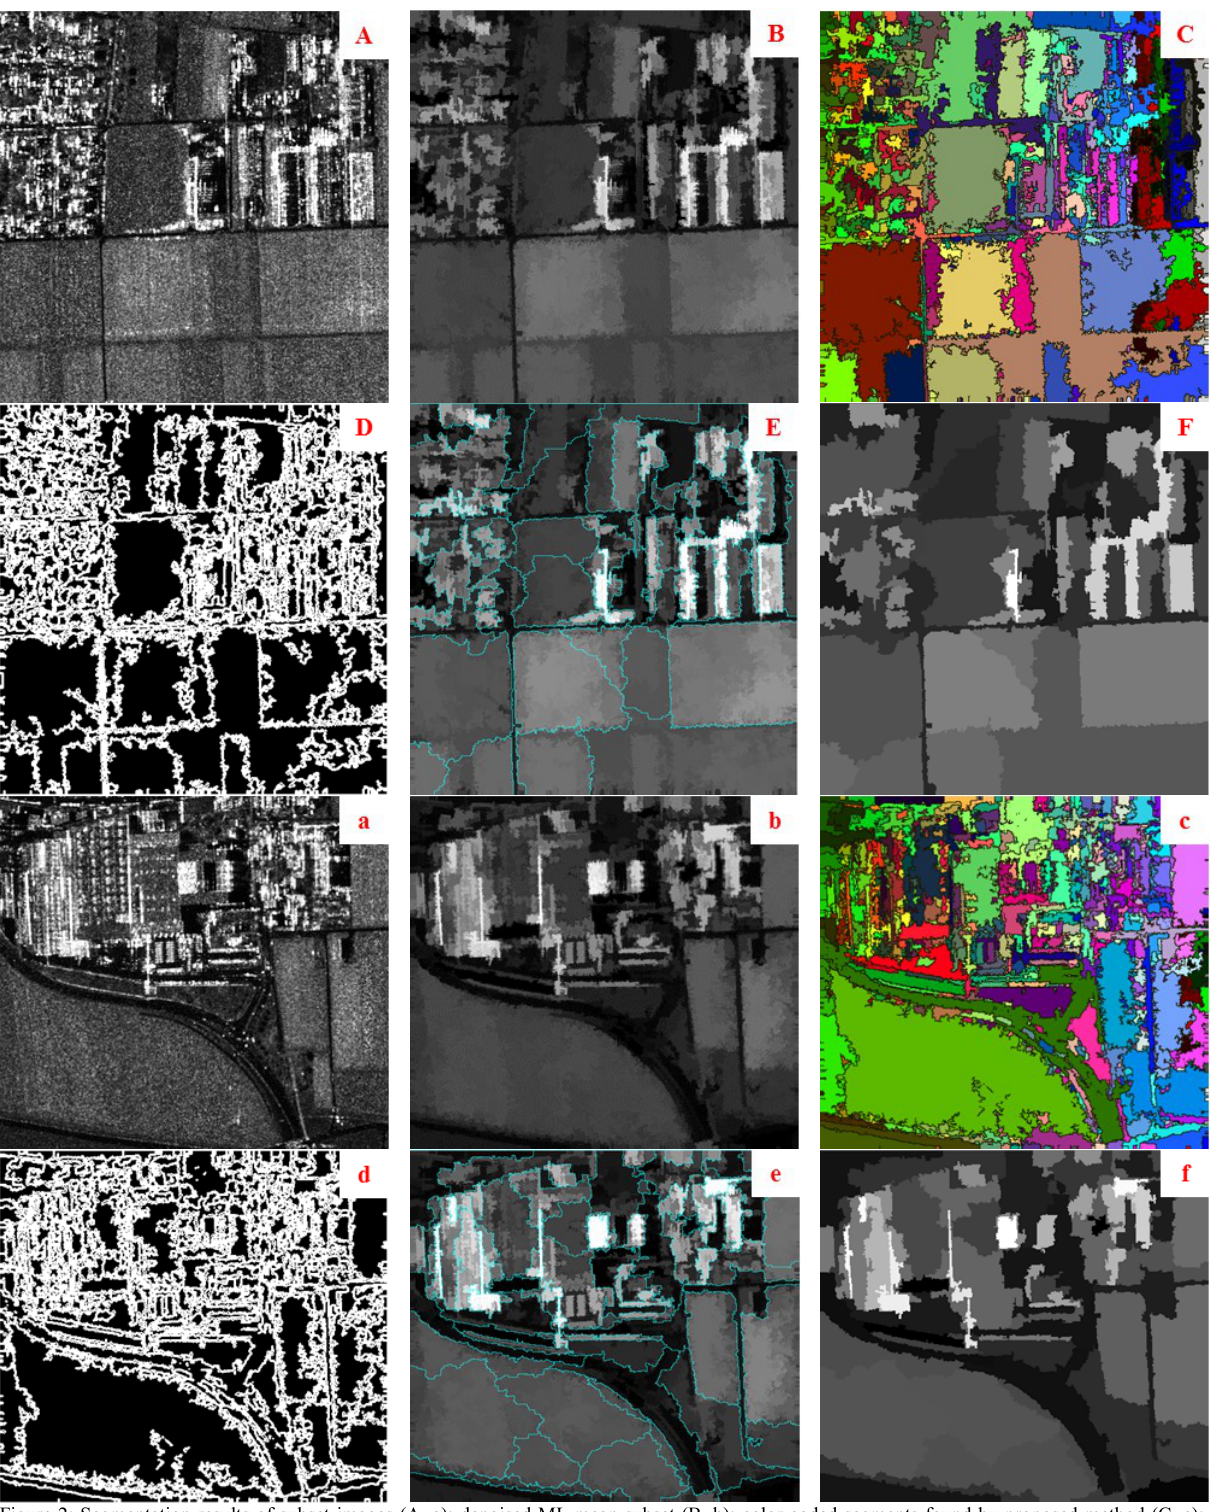
Figure 2: Segmentation results of subset images (A, a); denoised ML mean subset (B, b); color coded segments found by proposed method (C, c); outlines of segments found by proposed method (D, d); outlines of segments found by MRS method (E, e); visualized segment mean values found by MRS method (F,